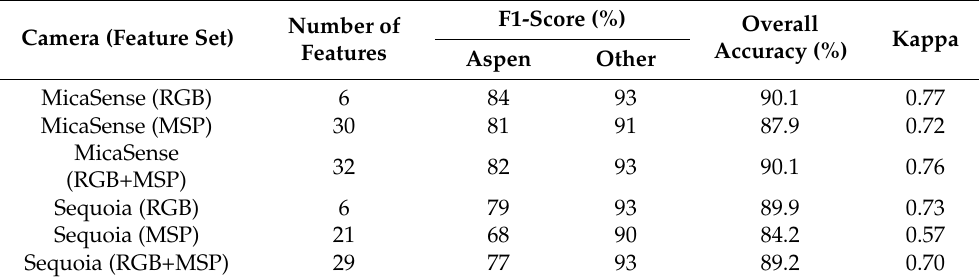
Table 2. Accuracy assessment of the 2-class classification model. MSP = spectral features extracted from multispectral mosaics, RGB = spectral features extracted from PPC.